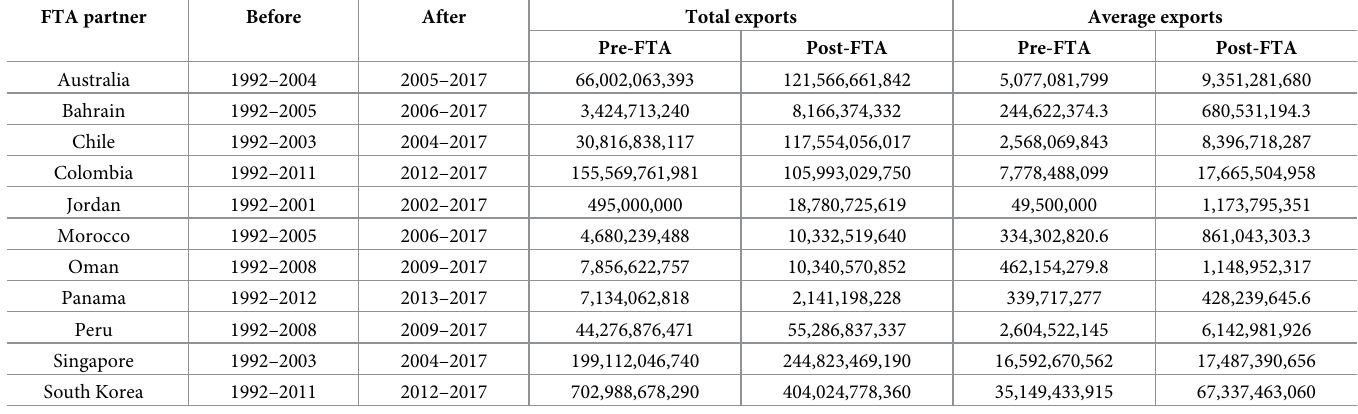
Table 4. Bilateral U.S export to its trade partner before and after FTAs entered into force. FTA